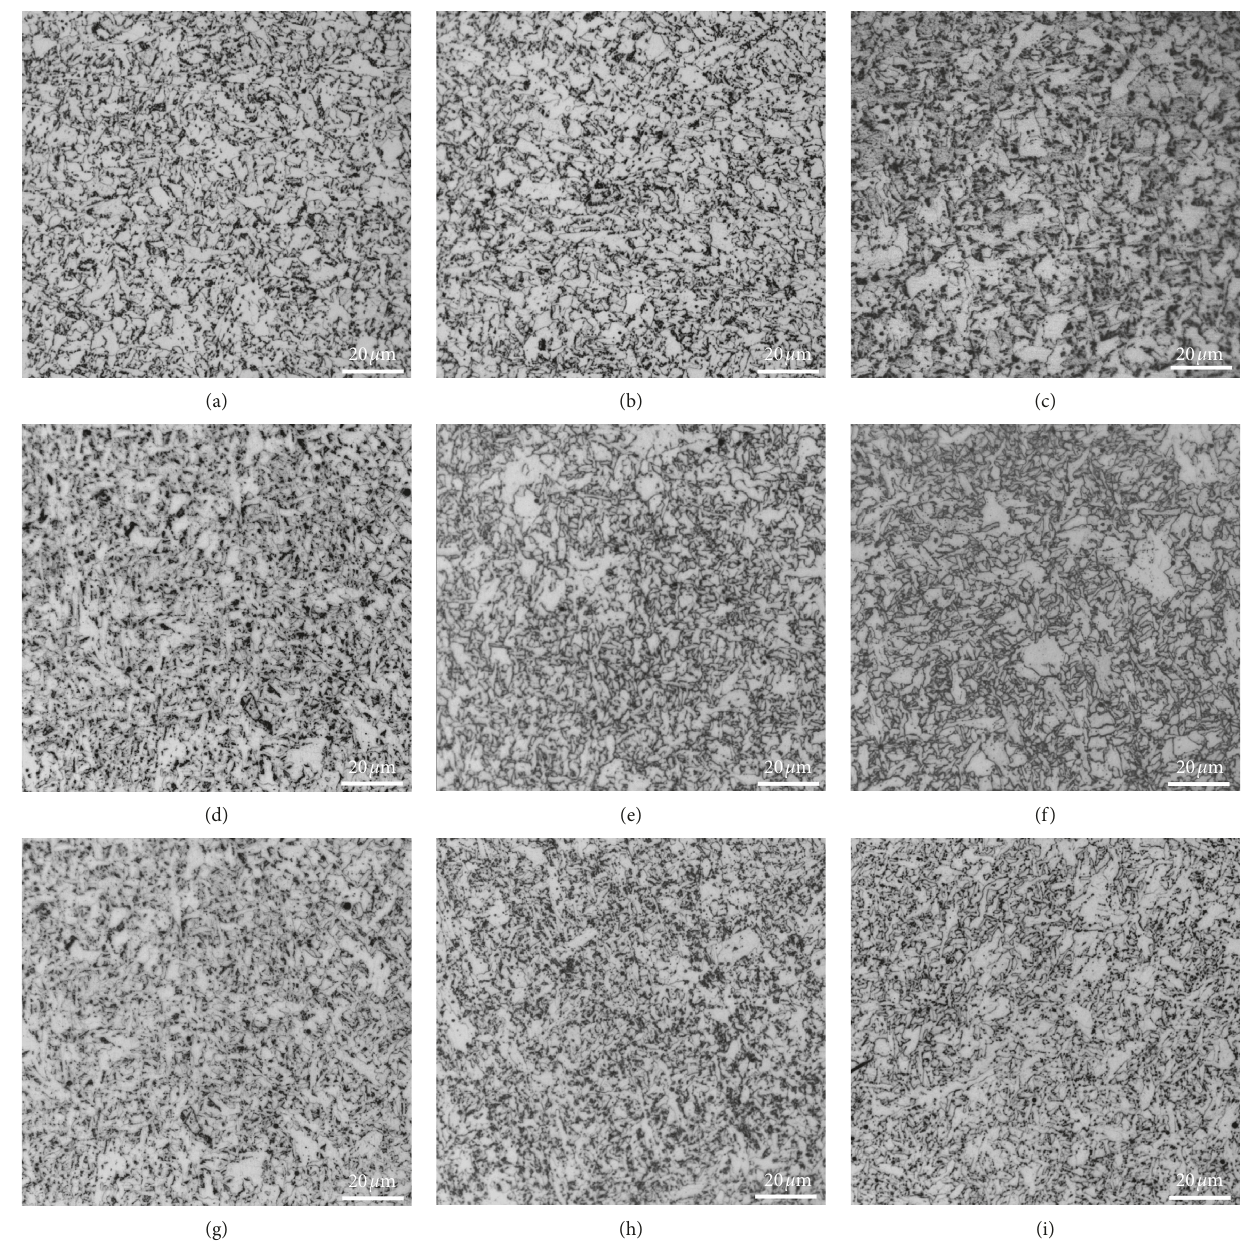
Figure 6: Optical microstructures of the weld metals tempered at different temperatures. Bend A: (a) 480 ° C; (b) 550 ° C; (c) 600 ° C. Bend B: (d) 550 ° C; (e) 620 ° C; (f) 680 ° C. Bend C: (g) 550 ° C; (h) 620 ° C; (i) 680 °